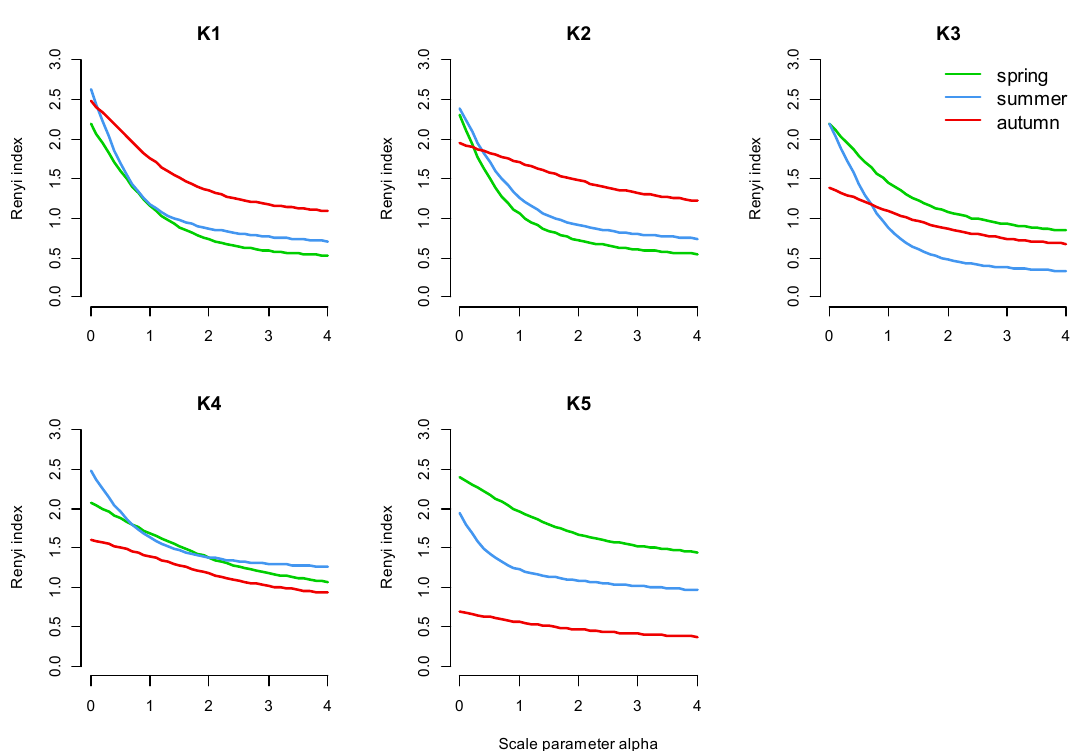
Figure 4. R é nyi diversity profiles of rotifer assemblages in di ff erent seasons per distance (K1–K5) from Figure 4. Rényi diversity profiles of rotifer assemblages in different seasons per distance (K1–K5) from the inflow point in the K á kafok oxbow the inflow point in the Kákafok oxbow lake.